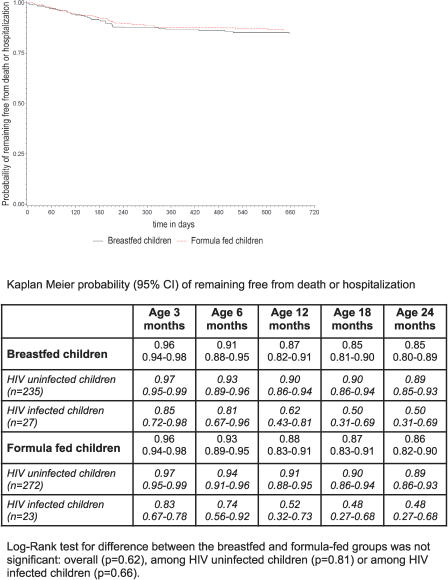
Two-Year Probability of Remaining Free from Severe Events (Hospitalization or Death) According to the Feeding Group and Pediatric HIV StatusANRS 1201/1202 Ditrame Plus study, Abidjan, Côte d'Ivoire, 2001–2005 (n = 557).